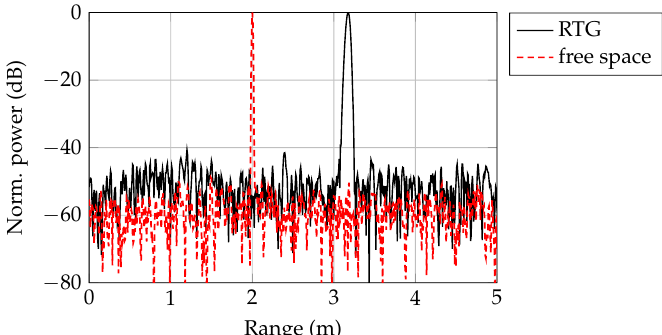
Figure 4. Range spectra, normalized to their respective peak power, for an frequency-modulated continuous wave (FMCW) radar in free space and with the radar target generator (RTG). The target is positioned at L mech = 2 m.